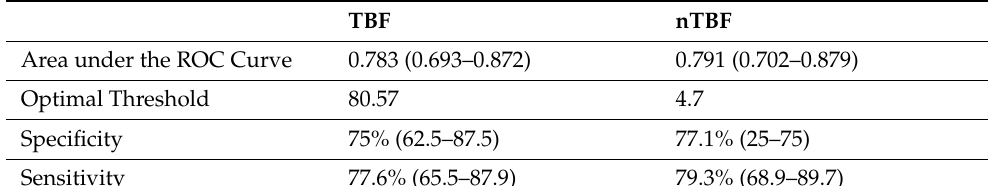
Table 2. ROC-analysis data comparing maximum TBF and maximum normalized nTBF in wildtype and IDH1-mutant gliomas.